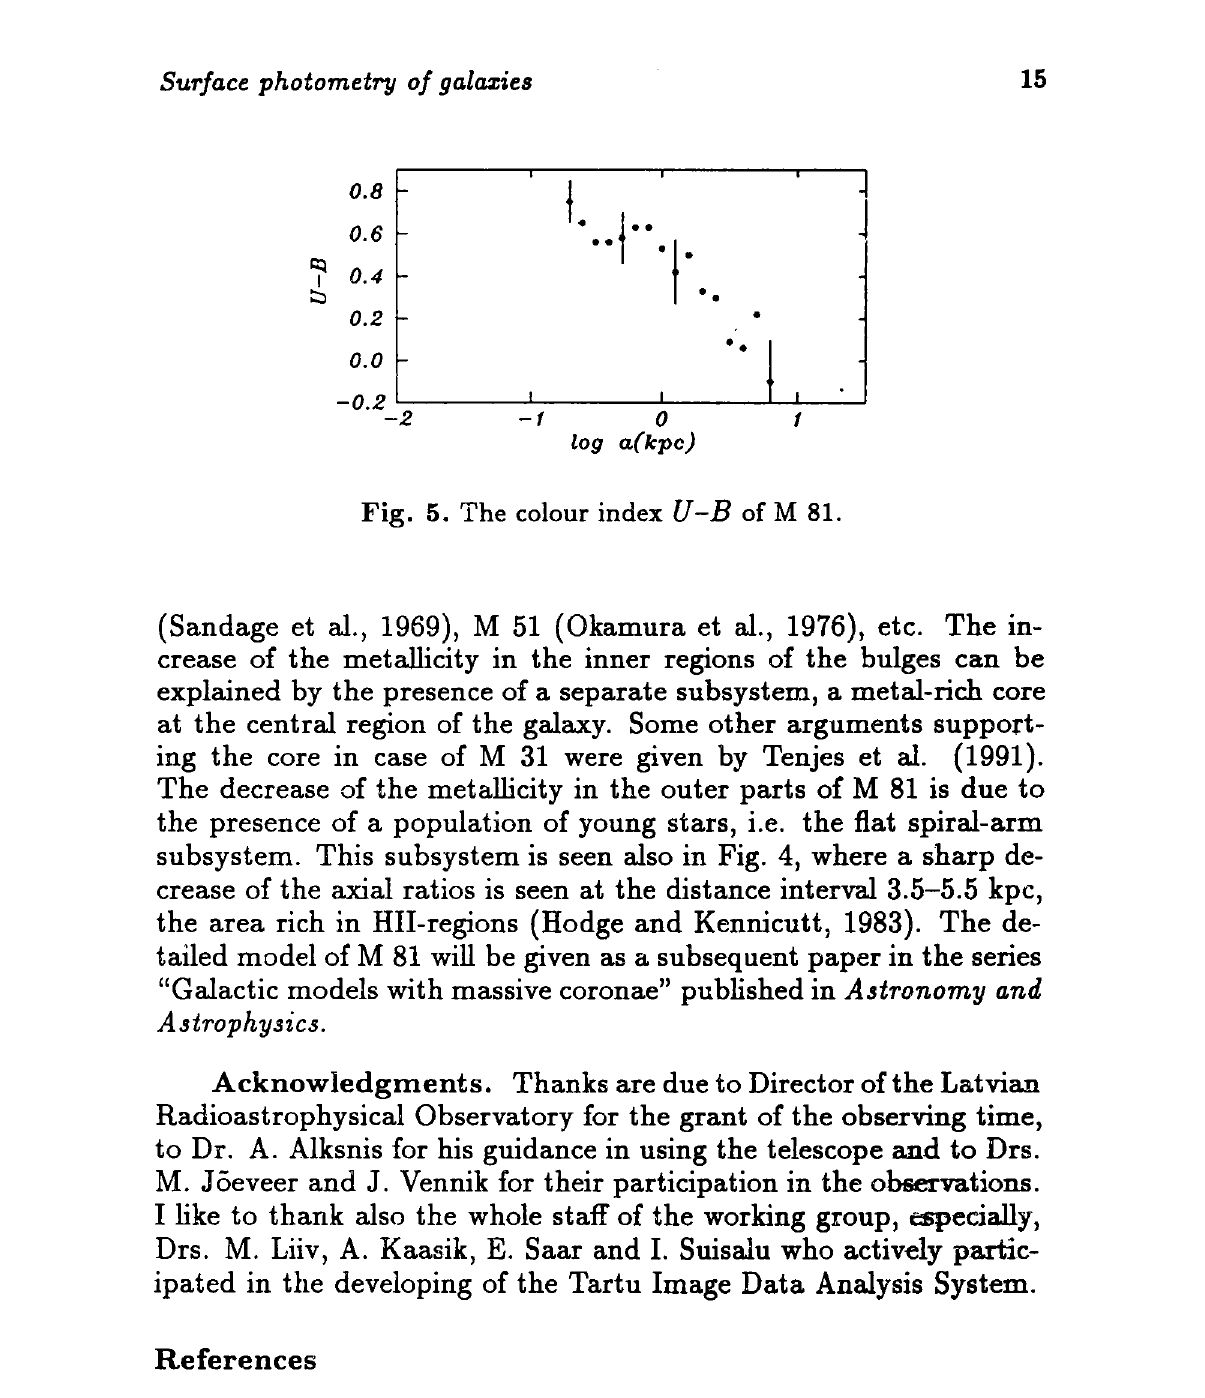
Fig. 5. The colour index U-B of M